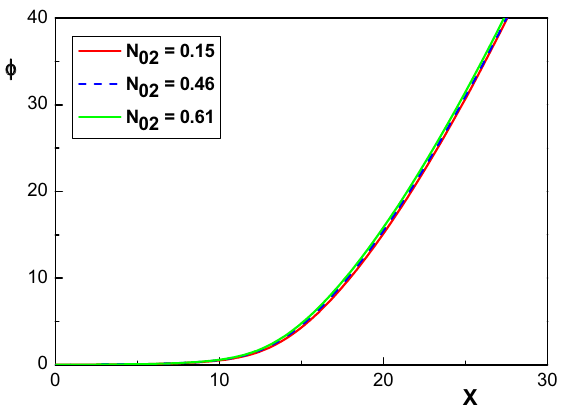
Figure 3. Variation of the normalized electrostatic potential φ versus the normalized distance from the sheath edge for different concentrations of krypton ions and the same parameters of Fig.